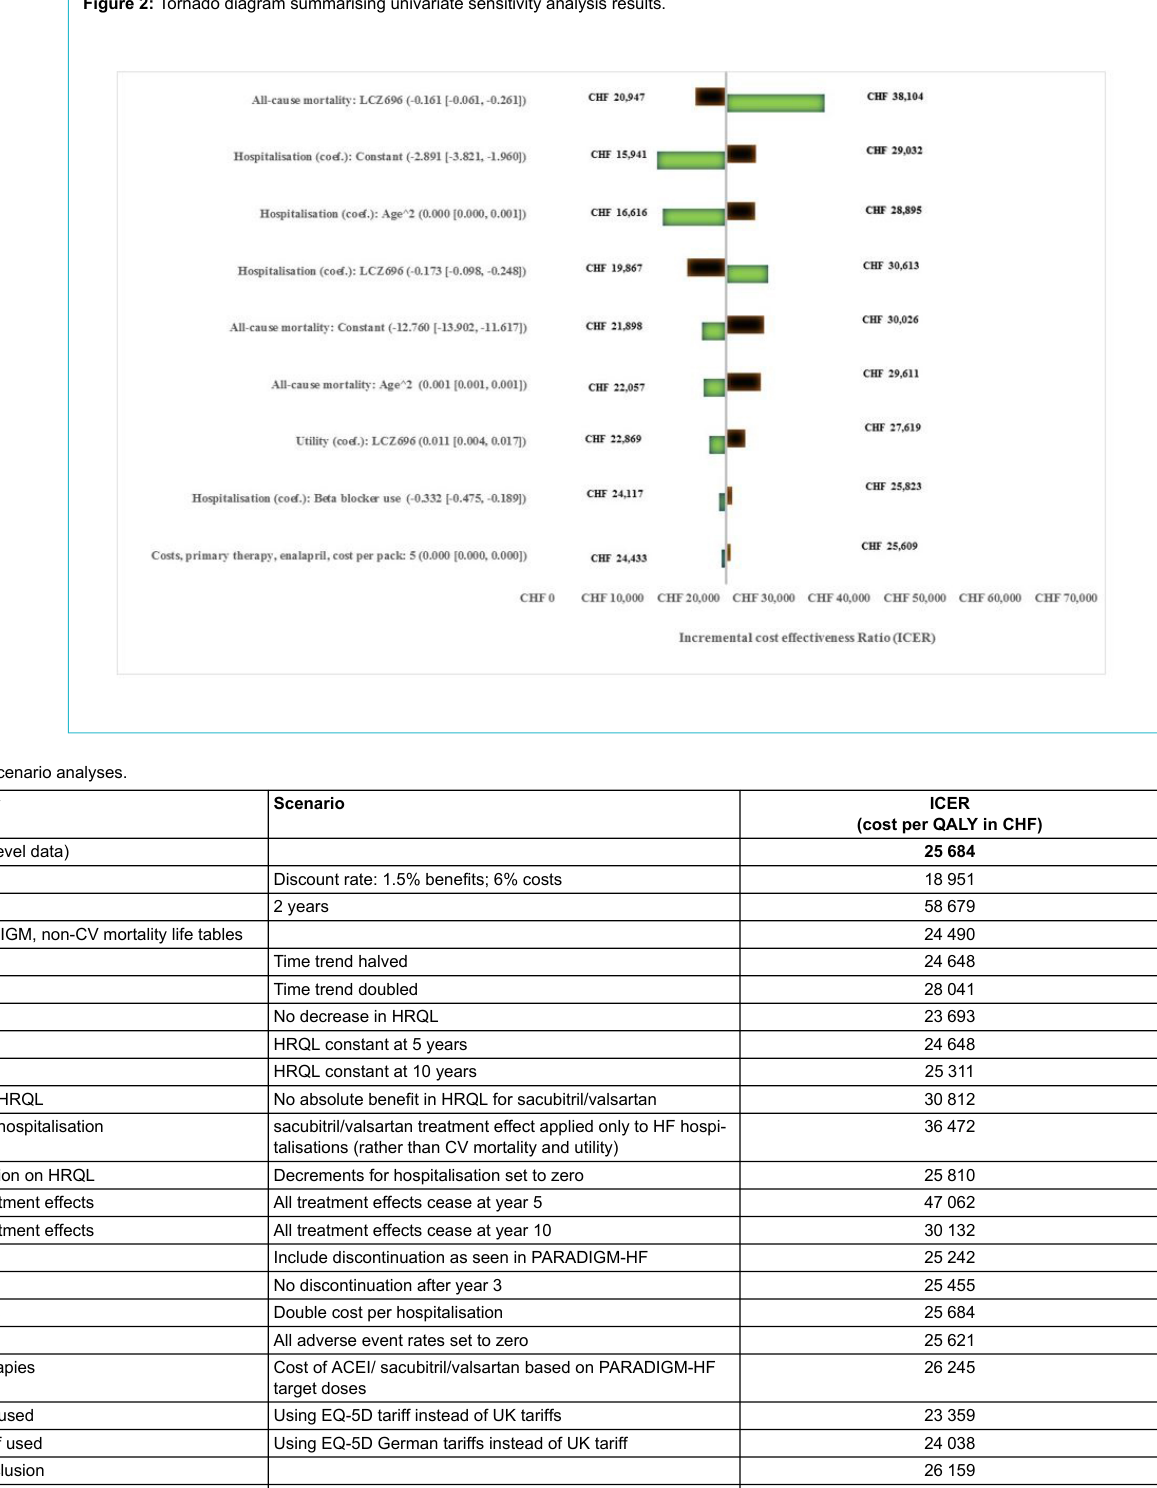
Figure 2: Tornado diagram summarising univariate sensitivity analysis results.